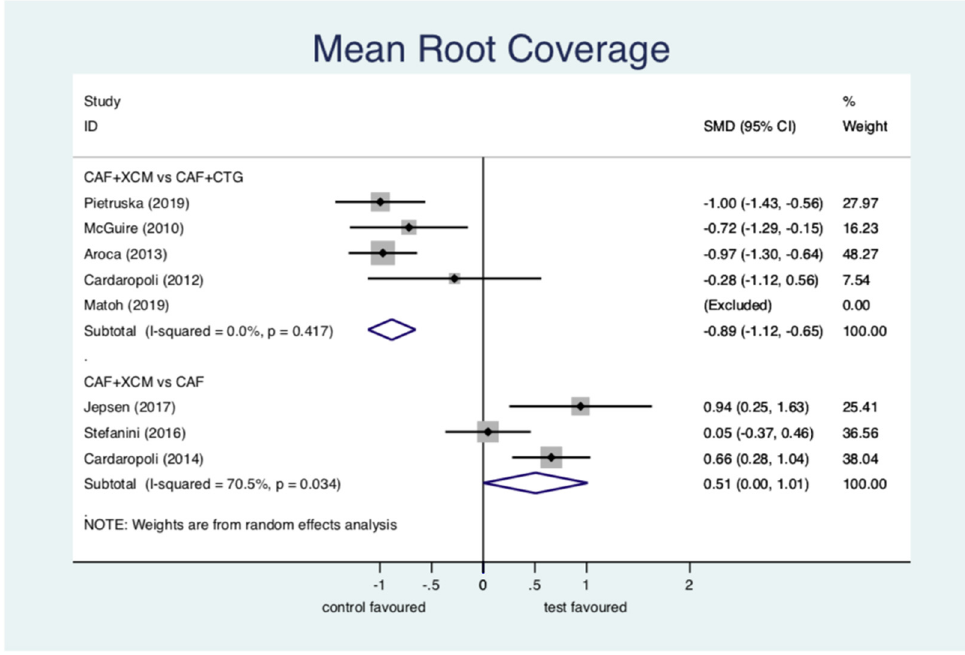
Figure 5. Forest plot relating to mean root coverage.